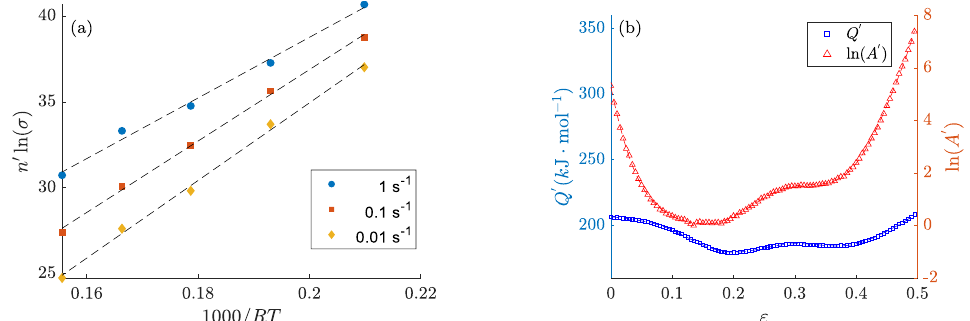
Figure A1. ( a ) The linear plots used for estimating the activation energy and the proportionality constant for the power law model. ( b ) The obtained ˙ ε -averaged Q (cid:48) and ln ( A (cid:48) ) .